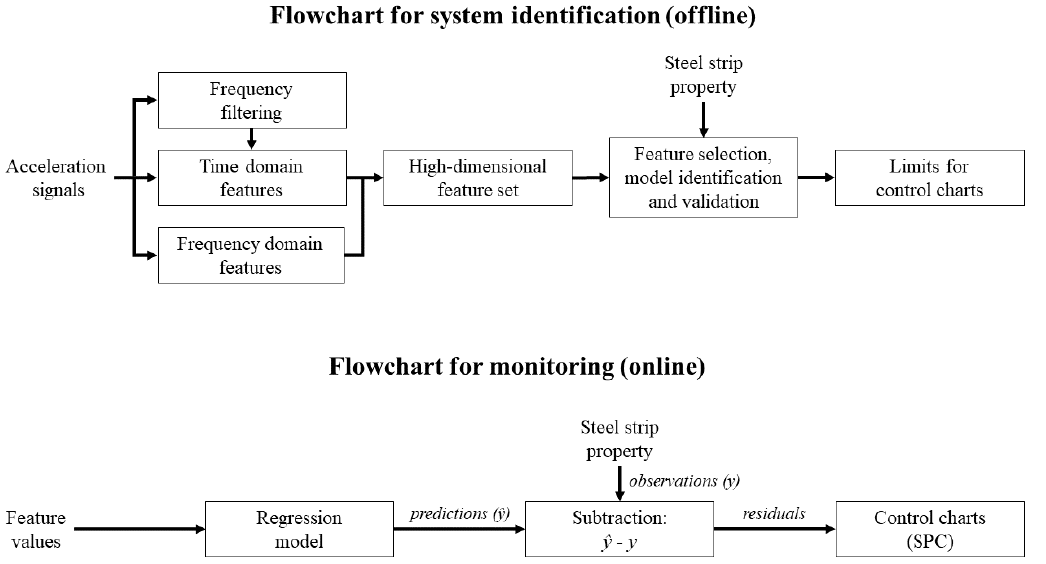
Figure 1. Flowcharts depicting the system identification and online monitoring procedures of the proposed approach to roller leveler monitoring.